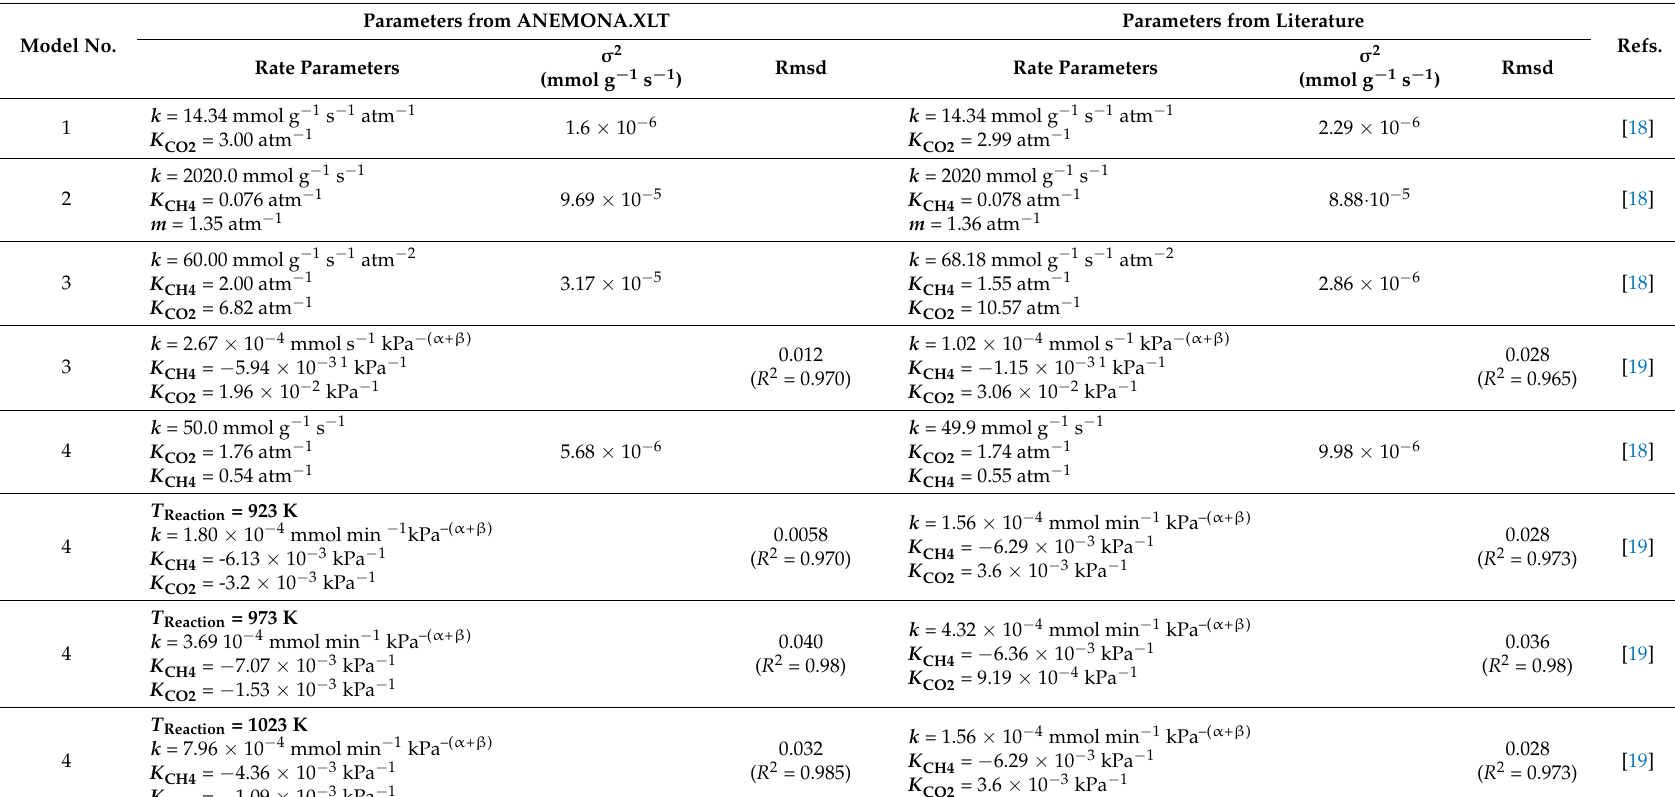
Table 1. Model parameters predicted by ANEMONA.XLT template compared with analogous literature data. Model